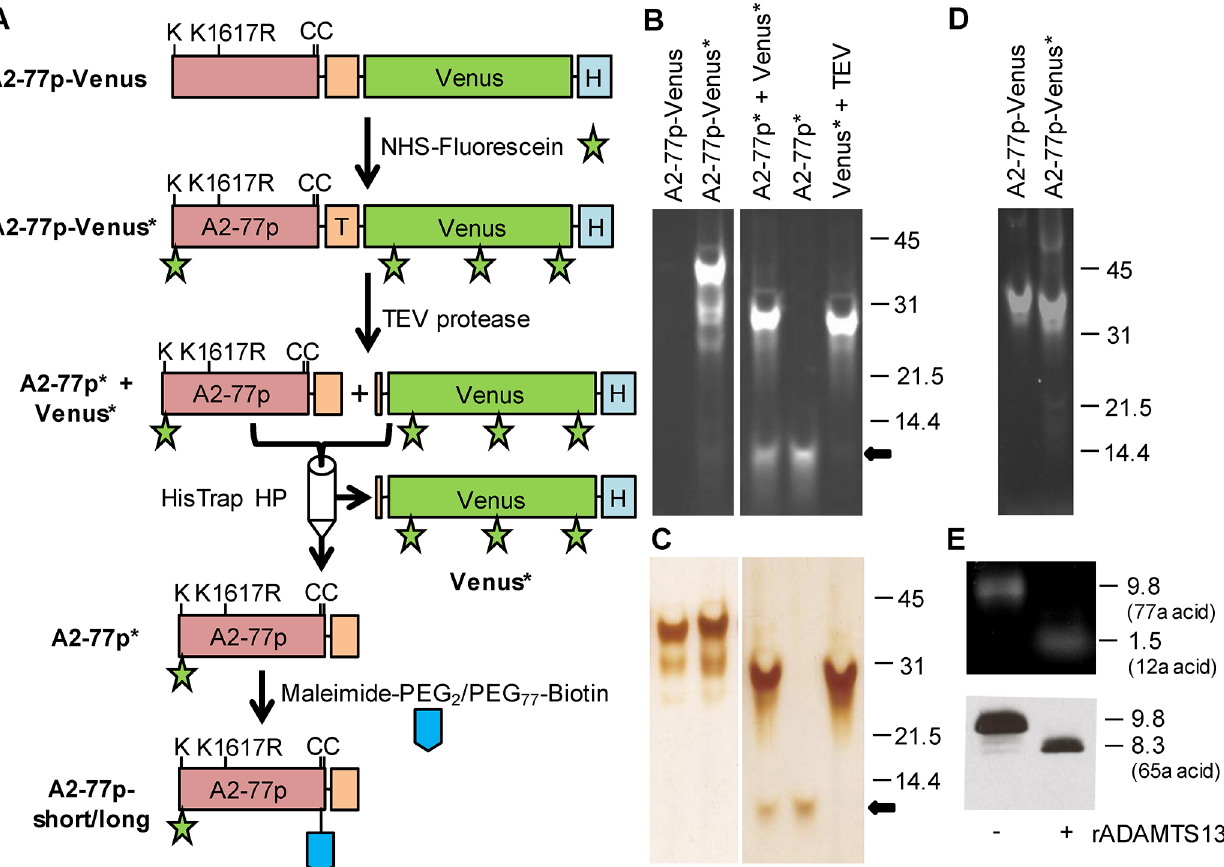
Fig 1. ADAMTS13 substrate synthesis. A. The 37.3 kDa fusion protein A2-77p-Venus, purified from E . coli , was labeled with fluorescein yielding A2-77p- Venus * . A2-77p-Venus * incubated with TEV protease resulted in two fragments A2-77p * and Venus * , which were separated using a HisTrap HP column. A2-77p * was coupled with a biotinylation linker that had either 2 or 77 PEG spacer units. The final product that is coupled to both fluorescein and biotin is called A2-77p-short (2 PEG units) or A2-77p-long (77 PEG units). A similar protocol was applied to create negative control proteins where residues Y1606 and M1605 were replaced by alanine. T — TEV cleavage site, H — 7x His tag. B. Starting material and intermediates resolved using a 4 – 20% gradient gel under reducing conditions. Fluorescence is due to fluorescein alone since Venus signal is lost upon boiling. C. Silver stain of gel in panel B. Peptide of interest (A2-77p * ) appears at 9.8 kDa (arrow). D. A2-77p-Venus (unlabeled) and A2-77p-Venus * (fluorescein labeled) resolved using a 4 – 20% gradient gel under non-reducing conditions. Fluorescence in the gel is due to both Venus and fluorescein. E. A2-77p-short was incubated with or without 4.4U/ml rADAMTS13 for 90min. Product was resolved using a tricine gel. Top panel shows fluorescence under UV illumination. Bottom panel shows western blot of the gel using anti-biotin antibody. As expected, the 9.8 kDa substrate is cleaved into 1.5 kDa fluorescent (top gel) and 8.3 kDa biotinylated product (bottom